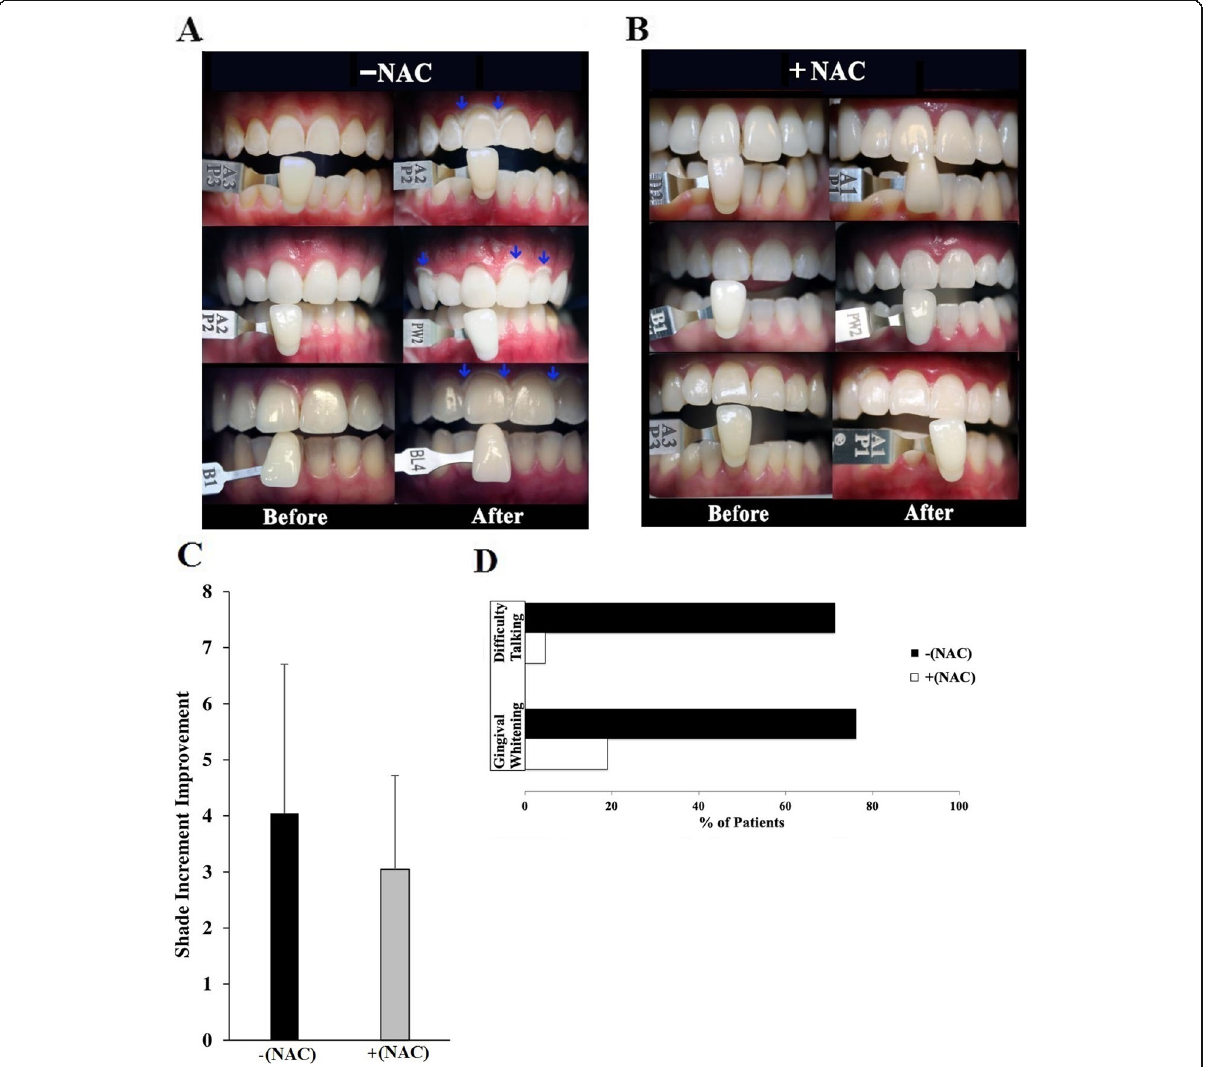
Fig. 4 NAC improves the extent of teeth whitening and prevents mucosal chemical burns of chair-side bleaching agents in patients. Clinical photographs of teeth after bleaching from patients in the control group (without NAC application) demonstrating VitaShade Classical, Vita Bleach and Portrait Bleach shade guides to match with the color of the teeth were taken. Arrows point to the white lesions in the gingival margins around teeth, one of several representative experiments is shown in this picture ( a ). Clinical photographs of teeth after bleaching from patients in the NAC group demonstrating VitaShade Classical, Vita Bleach and Portrait Bleach shade guides to match with the color of the teeth were taken. No or much lower levels of white lesions in the gingival margins around the teeth can be seen, one of several representative experiments is shown in this picture ( b ). VitaShade Classical, Vita Bleach and Portrait Bleach Guide are placed in a value-oriented order and given a score in increasing order from light to dark. Shade increment improvement scores for teeth color were determined by finding the differences of the before and after shade guide score. The scores indicated in the table below were used based on the shade guide. The average score was determined in control and NAC-treated groups and found to have no statistical significance ( p = 0.3276) ( c ) Clinical observations were recorded after bleach whitening treatment of patients in control (H2O) or NAC groups. Assessments were made based on patient ’ s ability to speak after the procedure due to discomfort, and the extents of whitening of the gingival tissues around the teeth after bleaching ( d